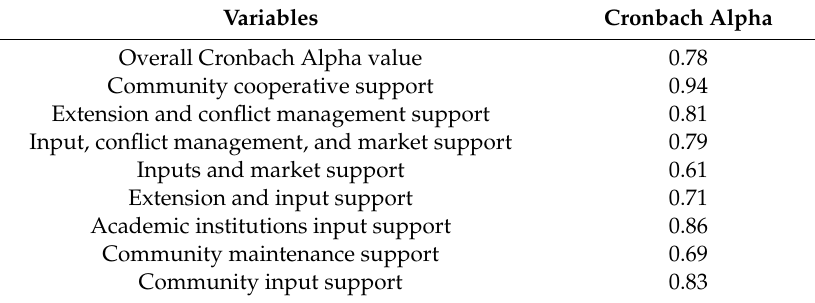
Table 5. Cronbach Alpha test for principal